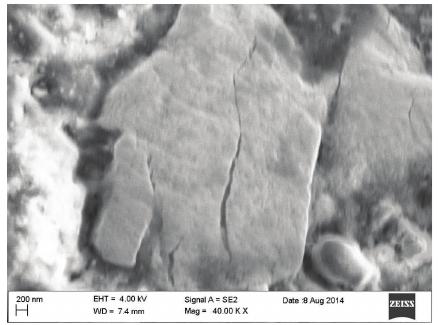
Figure 5: Coal/rock particle interruption (black portion) in between the WC